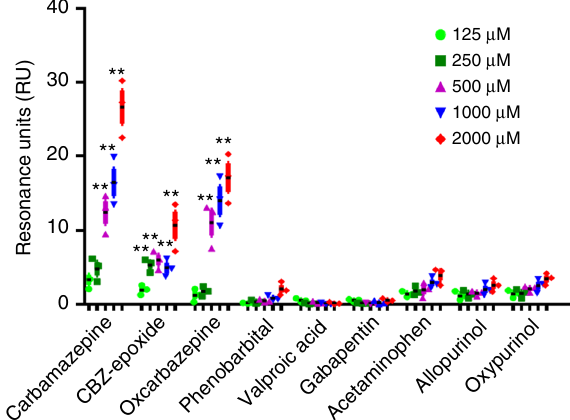
Fig. 5 Binding response of the public TCR to different drugs and structural analogs. Surface plasmon resonance (SPR) was applied for analyzing the binding response between the soluble single-chain αβ TCR (scTCR) recombinant protein and drug compounds. The scTCR composed of the TCR α CDR3 “ VFDNTDKLI ” and TCR β CDR3 “ ASSLAGELF ” was puri fi ed from the cultured medium of HEK293F transfectants. The scTCR protein was coated to the chip, and different drugs or metabolites fl owed through the chip. The binding response of the scTCR protein toward CBZ and related compounds was examined by SPR. The results are representative of three independent experiments, and expressed as mean ± s.e.m. with each dot representing the data of one sample. Statistical analysis was generated using an unpaired, two-tailed Student ’ s t test. ** P <